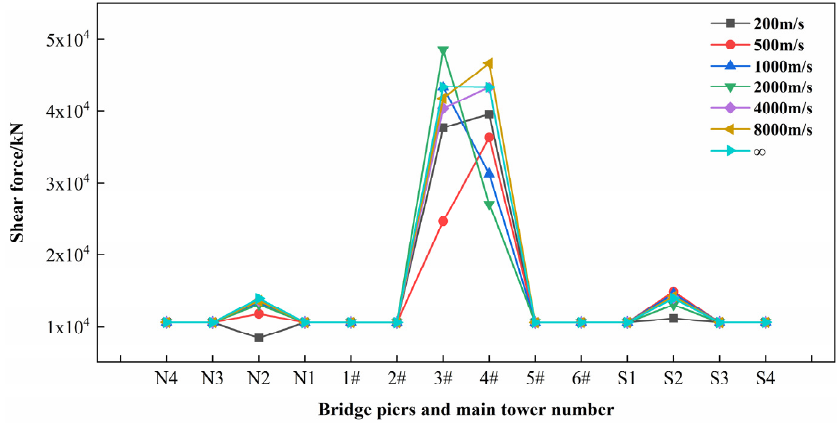
Figure 22. The absolute maximum value of shear force at different apparent wave speeds.